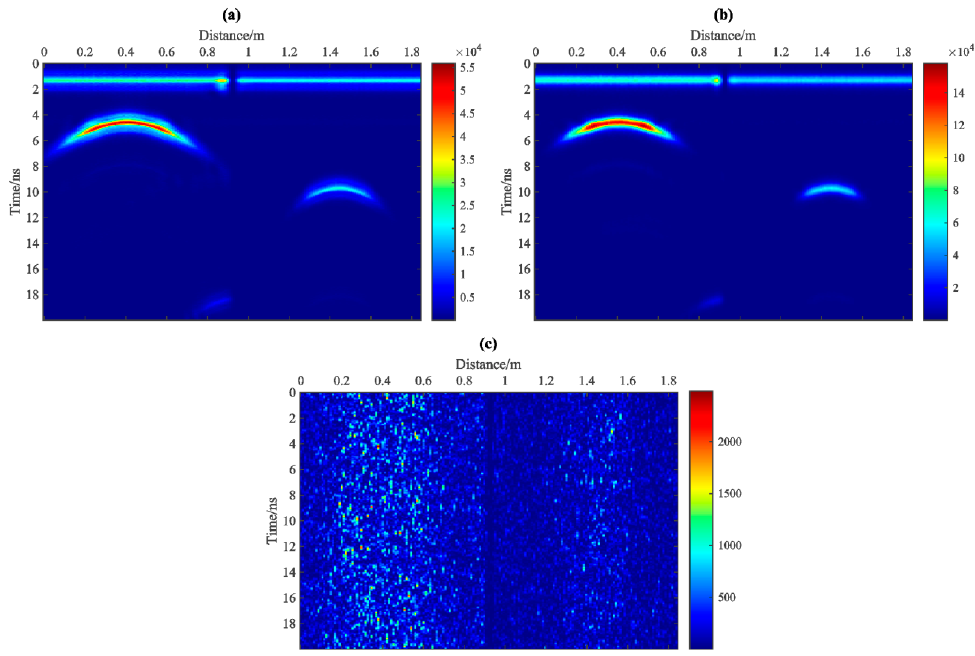
Figure 10. TKEO-slices of the model data using MVMD. ( a − c ) show the TKEO-slices 1 − 3, respec- tively.